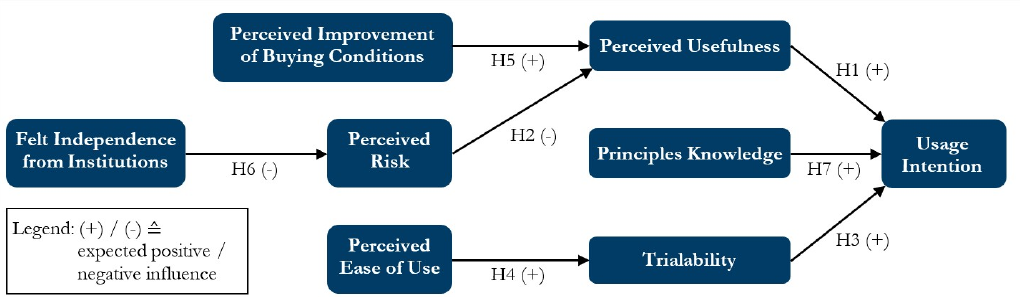
Figure 1. Research